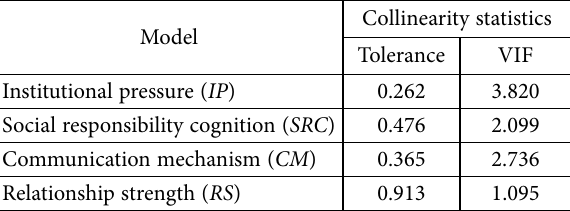
Table 4. Results of the multicollinearity test